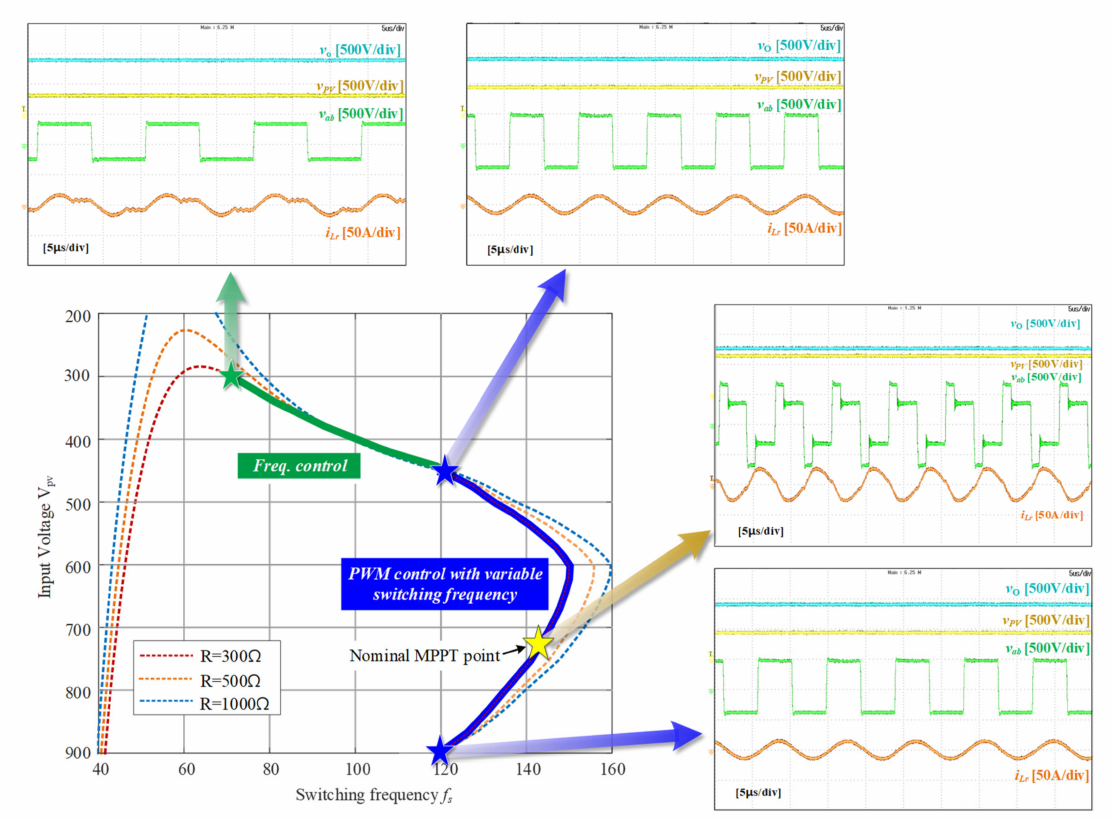
Figure 14. Experimental waveforms of the proposed hybrid control in a wide PV voltage